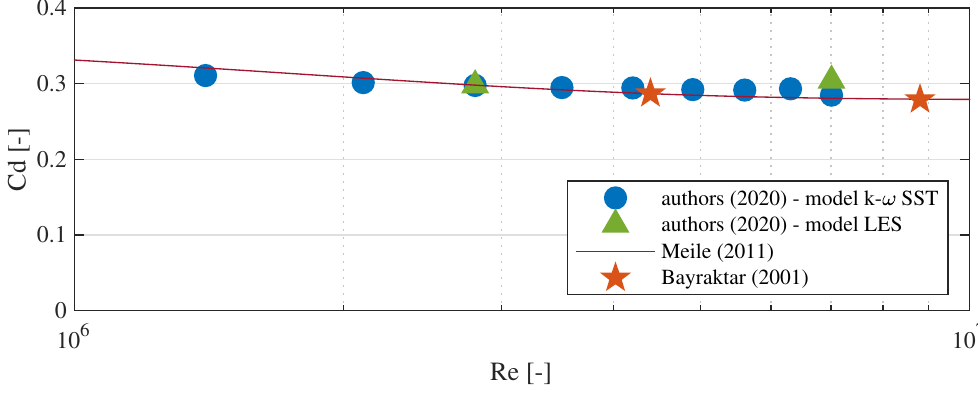
Figure 13. Drag coefficient (Cd) as a function of Reynolds number